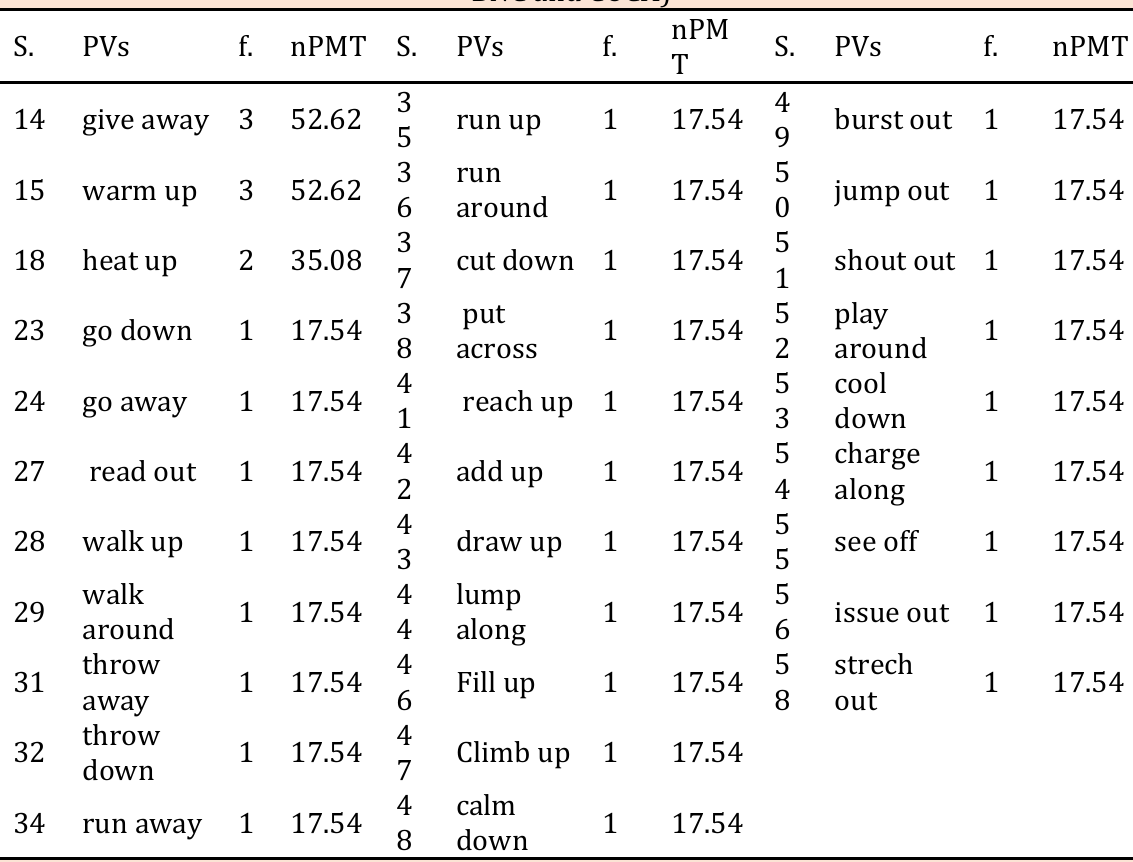
Table 6. The missing PVs in COCA and BNC with related corpus